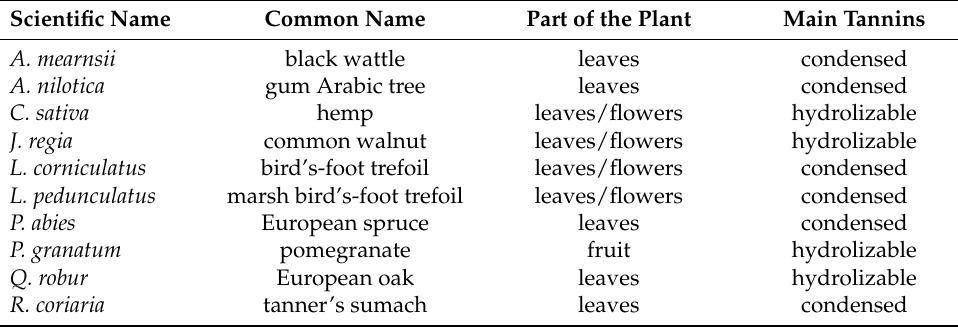
Table 2. Potential tannins’ source for animal feeding reported with their scientific name, common name, part of the plant richest in tannins and tannins’ chemical profile. Fodder and plants tannins source used for ruminants